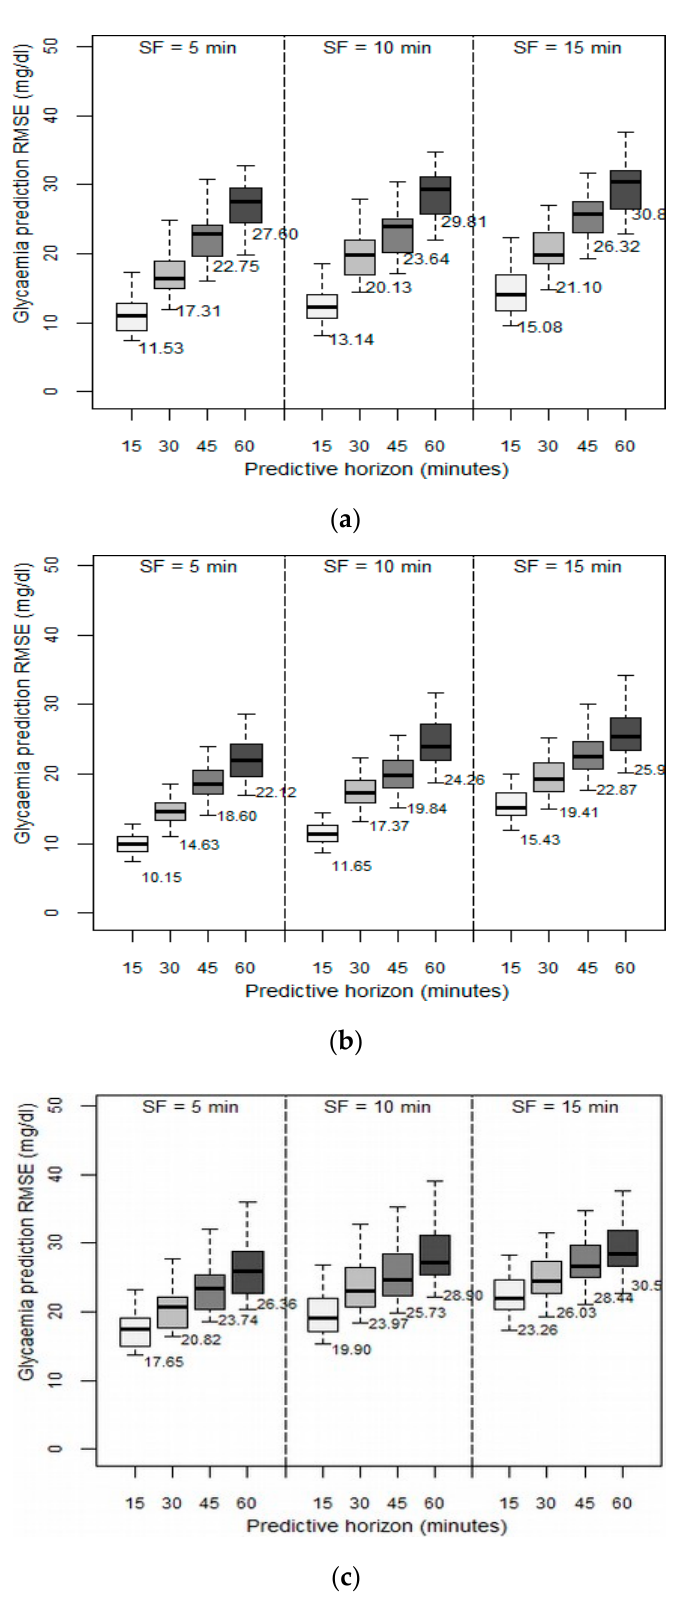
Figure 2. Root mean square error (RMSE in mg/dL) with fixed sampling frequency: ( a ) Autoregressive integrated moving average (ARIMA), ( b ) random forest (RF), and ( c ) support vector machine (SVM) with past sliding window sizes (PSWs) of 3, 6, 12, 24, 36 h; predictive horizons (PHs) of 15, 30, 45, and 60 min; and sampling frequency (SF) of 5 min.